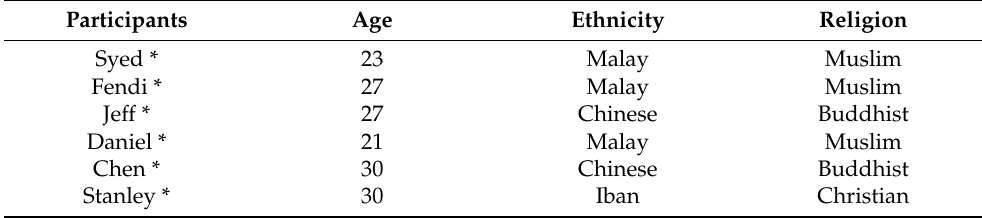
Table 1. The participant’s demographic information. Participants Age Ethnicity Religion Syed *